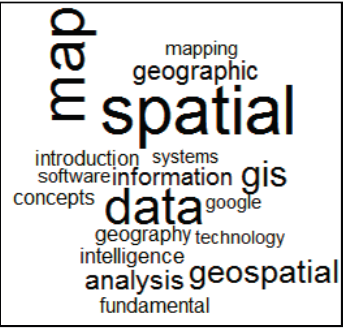
Figure 1. Word cloud of GeoMOOCs syllabi.